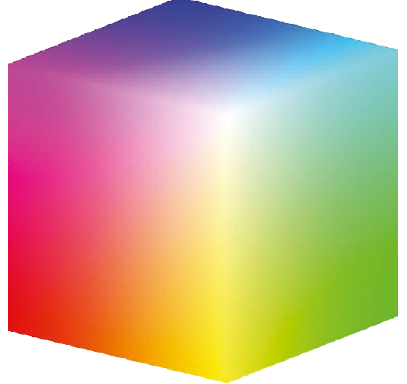
Figure 1: The RGB color